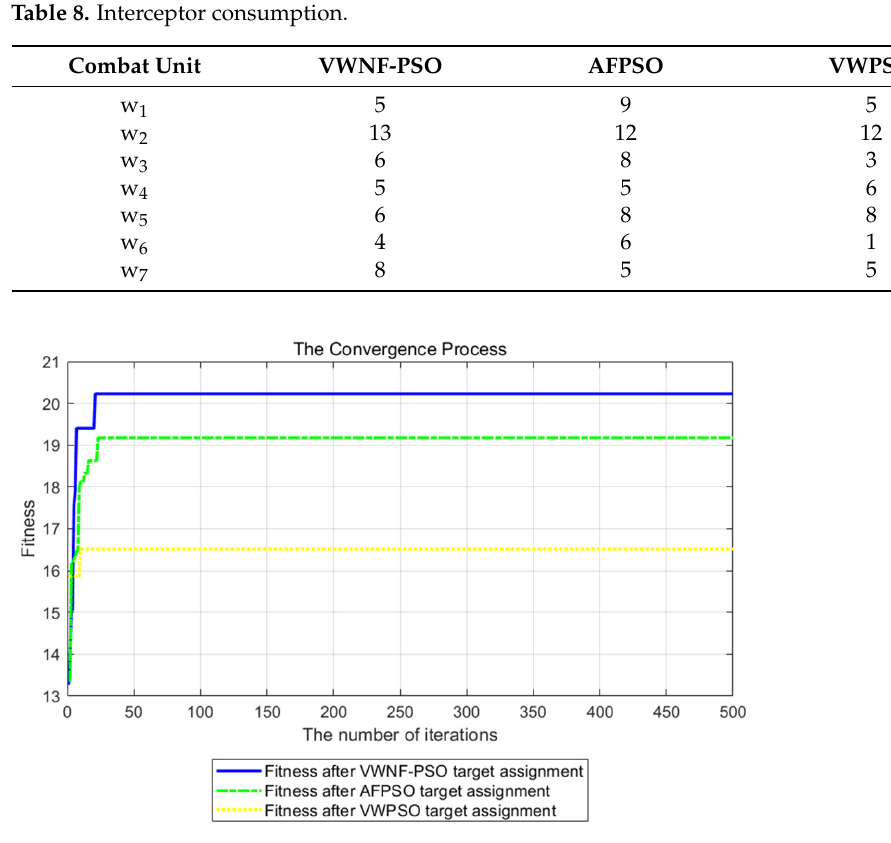
Figure 9. Number of interceptors consumed. 4.2. Large ‐ Scale Experimental To verify the adaptability of the model algorithm in dealing with large ‐ scale scenar ‐ ios, we set 60 future targets (missile1–missile60), under the condition that the number, type, and deployment position of combat units are not changed. Among them, incoming targets 1–20 are anti ‐ radiation missiles, 31–50 are cruise missiles, and 21–30 and 51–60 are jamming targets, the electronic jamming ability of cruise missiles is strong, the electronic